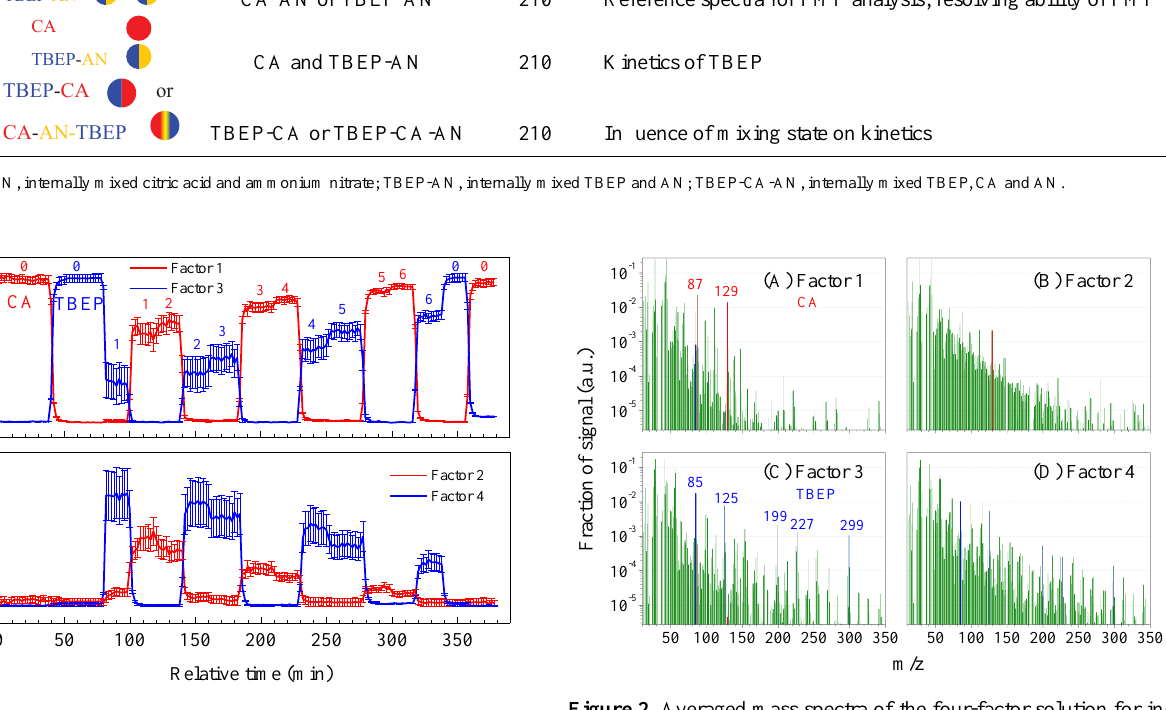
Figure 1. Averaged concentration profiles of the four-factor so- lution for individually oxidized TBEP-AN and CA-AN parti- cles. The number 0 represents an OH exposure of zero, while the numbers from 1 to 6 represent OH exposure decreases from (7.8 ± 0.8) × 10 11 to (8.5 ± 0.8 × 10 10 )moleculescm − 3 s the uncer- tainty in the rotations of the PMF analysis.